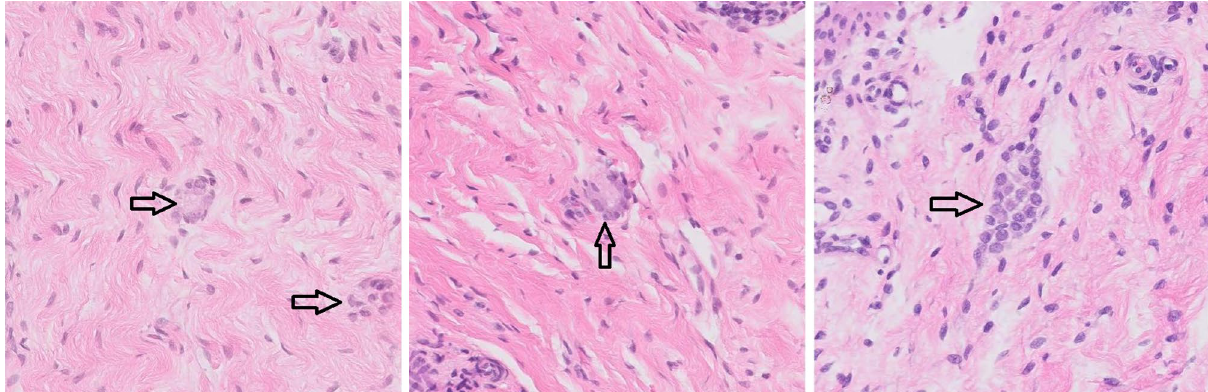
Figure 2. Immature ganglion cells. Examples from non-HSCR cases without evidence of mature ganglion cells. Clusters of immature ganglion cells are marked by black arrows. Note the smaller nuclei, inconspicuous nucleoli and scant intensely stained